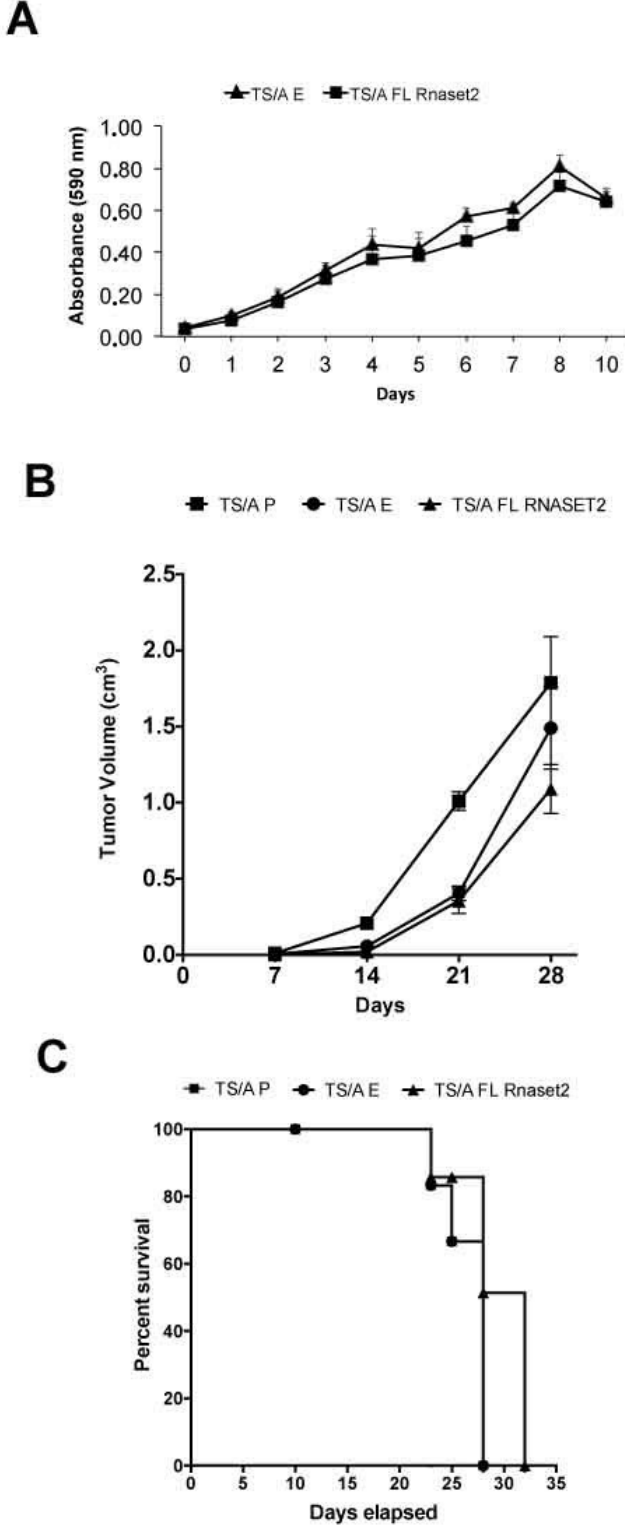
Figure 2. Assessment of in vitro cell proliferation rate (MTT assay) in full length Rnaset2 -overexpressing TS / A clones (FL Rnaset2 ) in comparison to empty vector-transfected TS / A clones (TS / A E) (panel A ) and in vivo analysis of tumor growth in BALB / c mice groups ( N = six animals in group) injected with TS / A P, TS / A E, and TS / A FL Rnaset2 cell lines (panel B ). Survival curves versus time (days) of BALB / c mice groups injected with TS / A P, TS / A E, and TS / A FL Rnaset2 cell lines (panel C